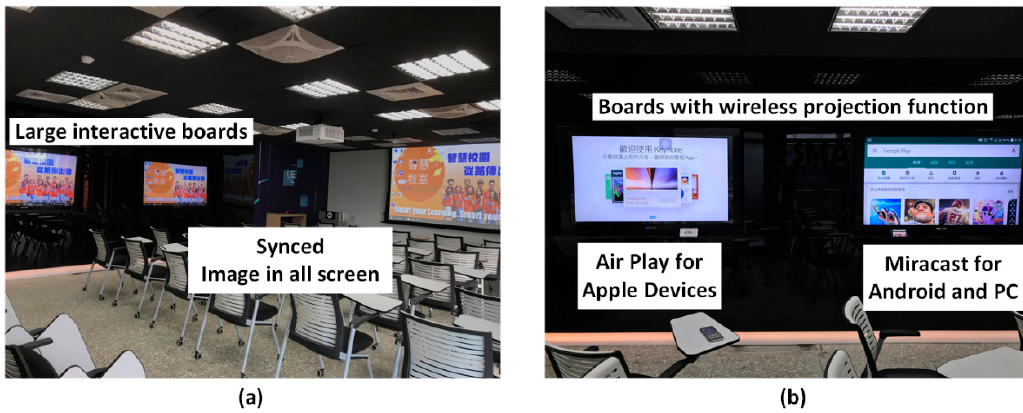
Figure 5. Advanced interaction experience: ( a ) large interactive boards for group discussion. Images can be synchronized on all screens; ( b ) wireless display function for interactive boards.